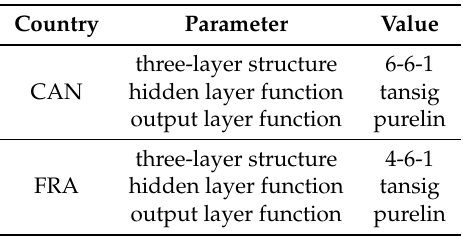
Table 2. Network